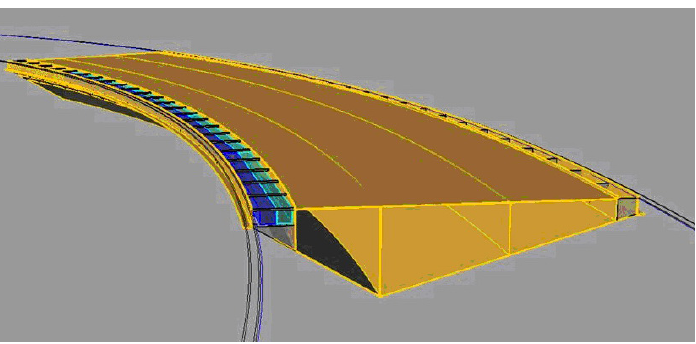
Figure 11: The steel box girder as the backbone of the